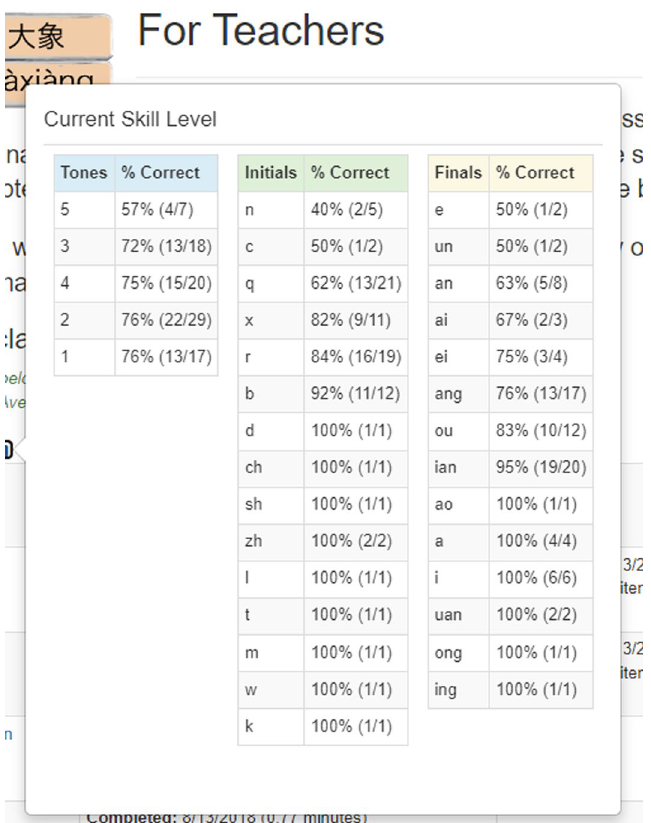
Fig. 2 Example of the class performance profile after a training at the Pinyin